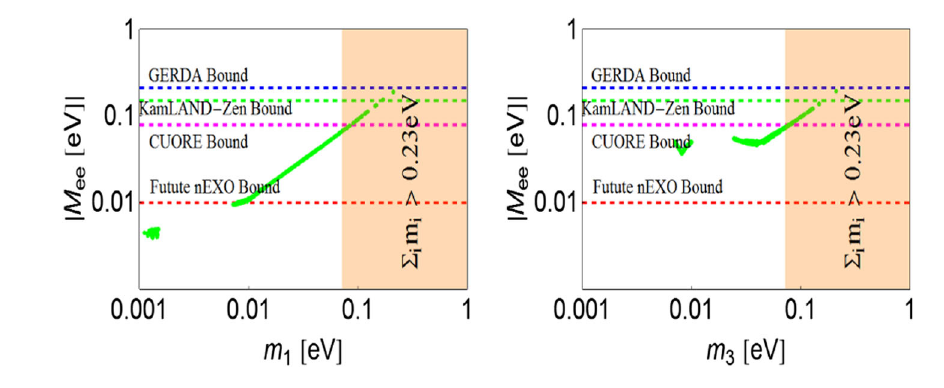
Fig. 8 Variation of effective Majorana parameter M ee , which is a measure of lepton number violation with the lightest neutrino mass for the case of the normal (left panel) and the inverted hierarchy (right panel) for tan ψ (cid:13)=